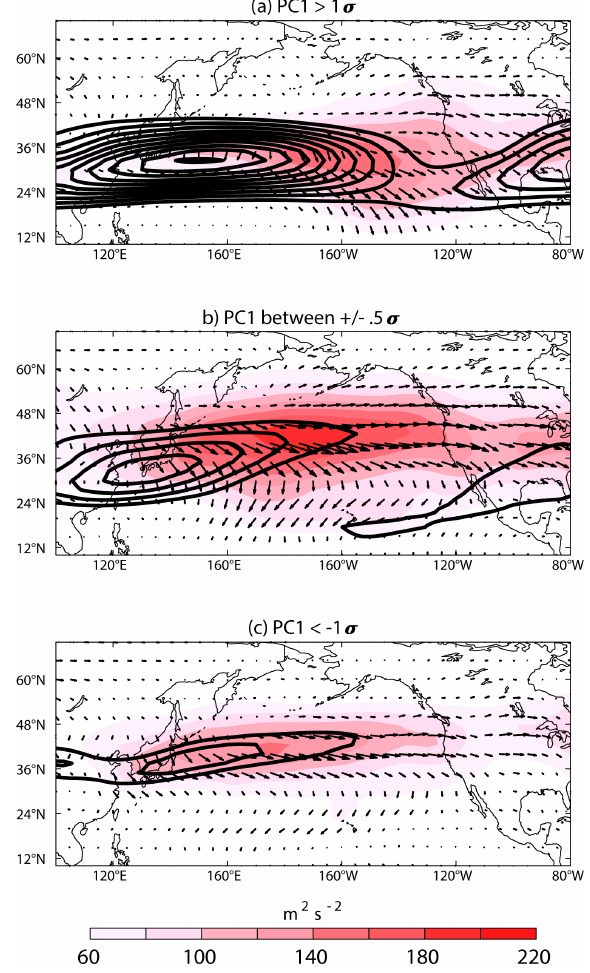
Figure 2. The black contours show the full-field 200hPa zonal wind composited for days characterized by (a) positive PC1 ( N = 1720), (b) neutral PC1 ( N = 1455), and (c) negative PC1 ( N = 1855). Zonal wind contours start at 30ms − 1 at intervals of 5ms − 1 . The color shading shows the composite high-frequency EKE during the positive, neutral, and negative jet phases, and the corresponding composite horizontal E vector is shown in the black